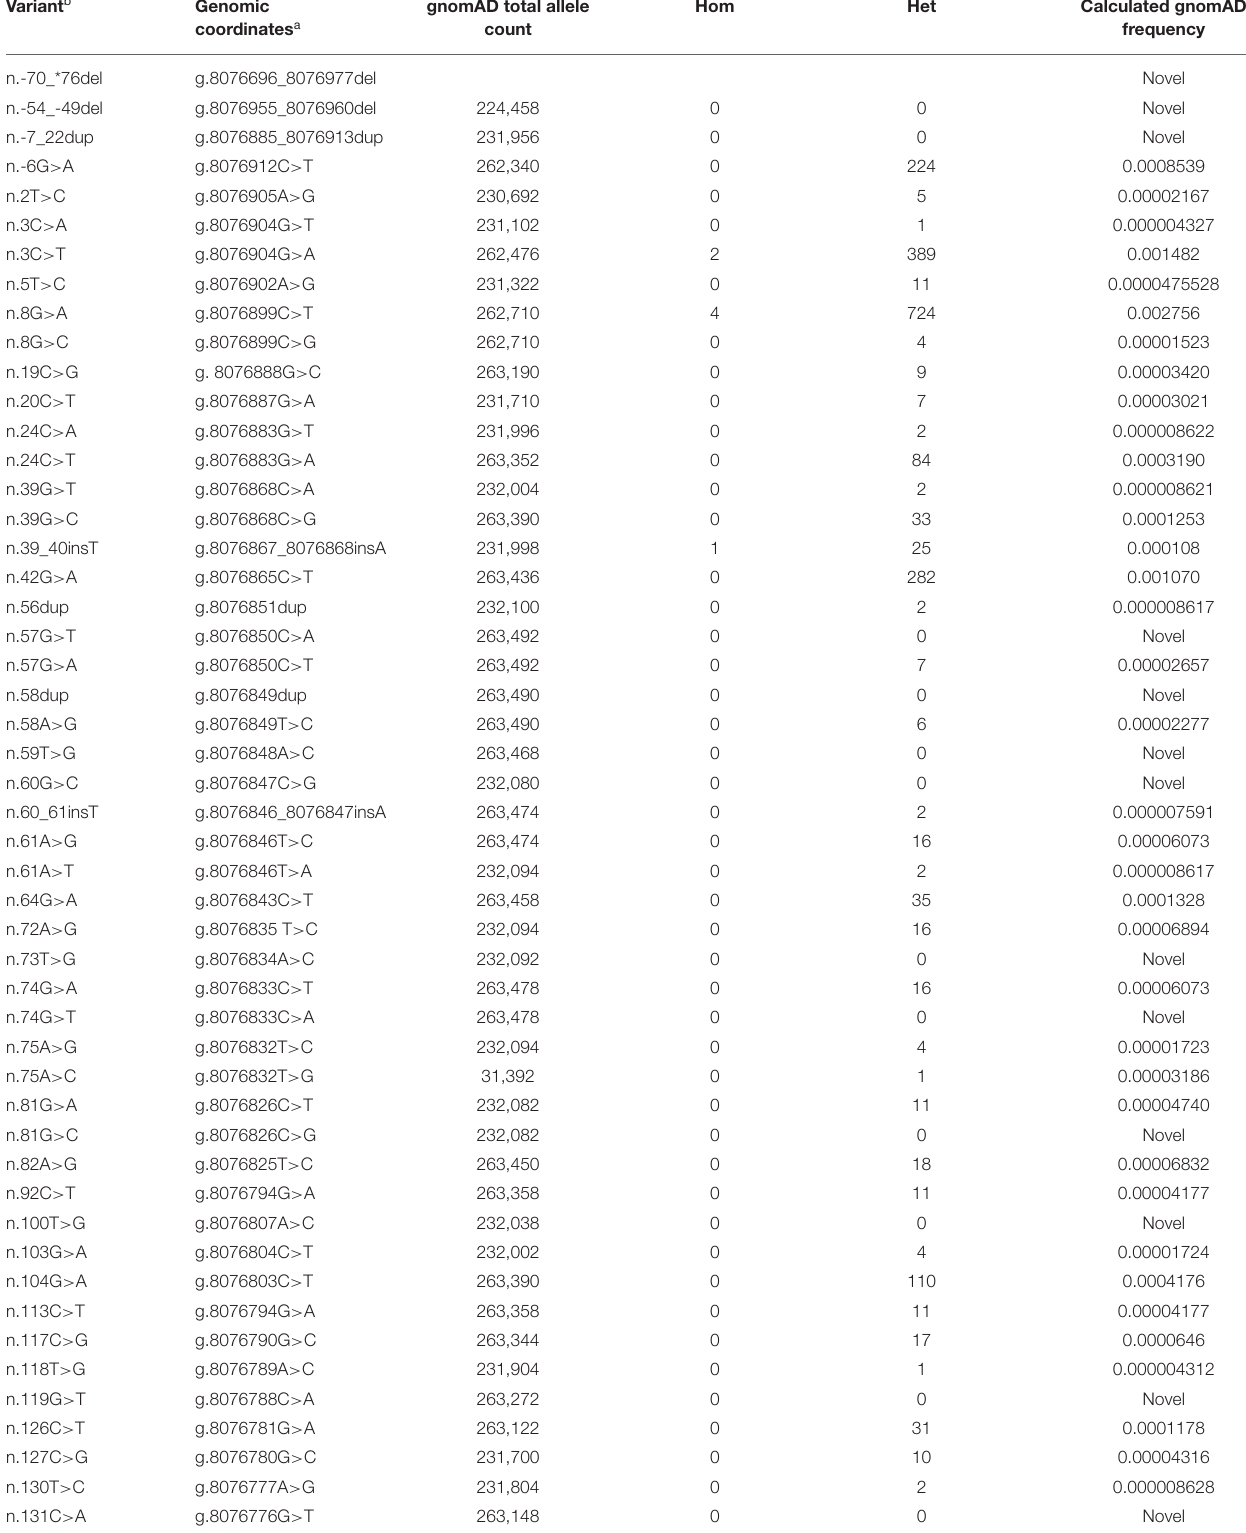
TABLE 1 | SNORD118 variants identified in patients with